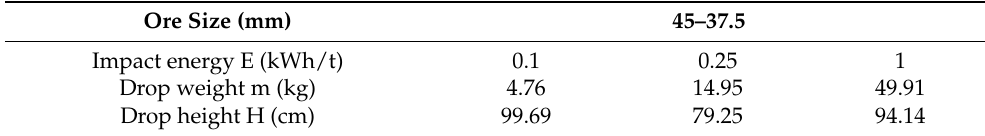
Table 1. Drop weight test parameters.